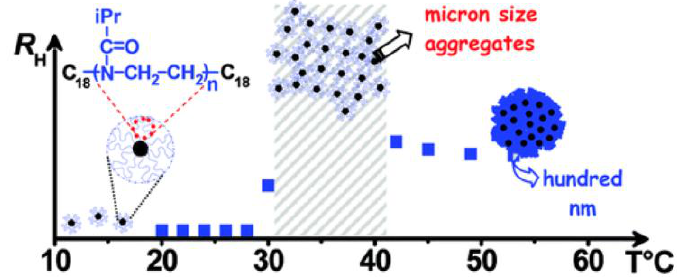
Figure 3. Temperature dependent association of α,ω -octadecyl end-functionalized PiPrOx [47], reproduced by permission of the American Chemical